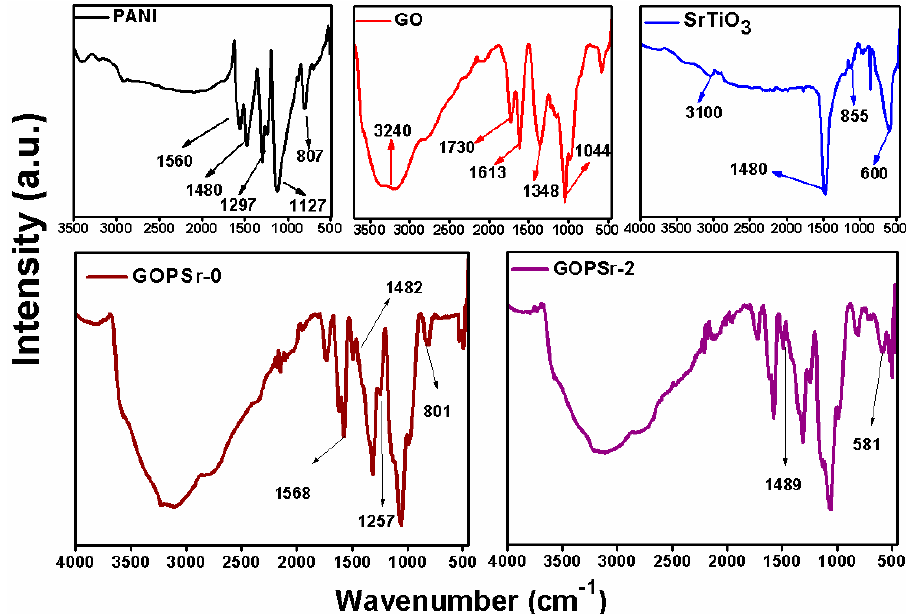
Figure 3. FTIR spectra of PANI, GO, SrTiO 3 , GOPSr-0, and GOPSr-2.